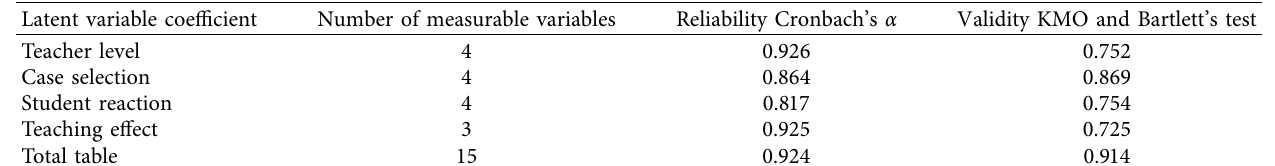
Table 2: Reliability and validity test.